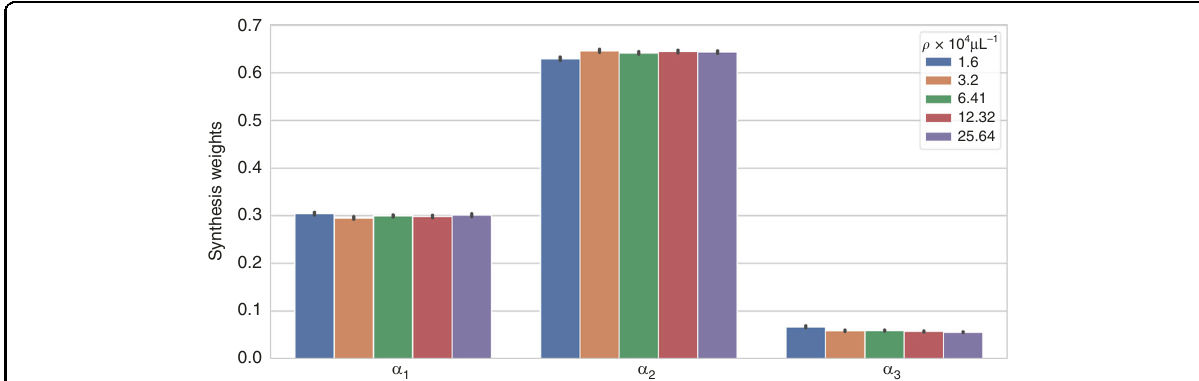
Fig. 7 Synthesis weights of the simulator-trained DSN for experimental data. The synthesis weights computed for the experimentally measured holograms match well with the corresponding simulation results. The mean and standard deviation of each synthesis weight are calculated from 640 non-overlapping hologram patches from 10 experimentally measured holograms for each particle density. This analysis shows that the simulator- trained DSN can robustly adapt to experimental